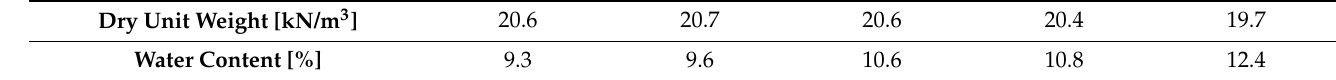
Table 2. Water content according to dry unit weight.